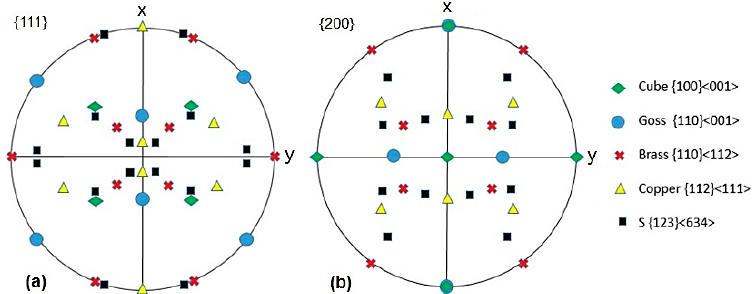
Figure 11. The typical orientation and ideal texture of a face centered cubic material in: ( a ) {111} and ( b ) {200} pole figures.